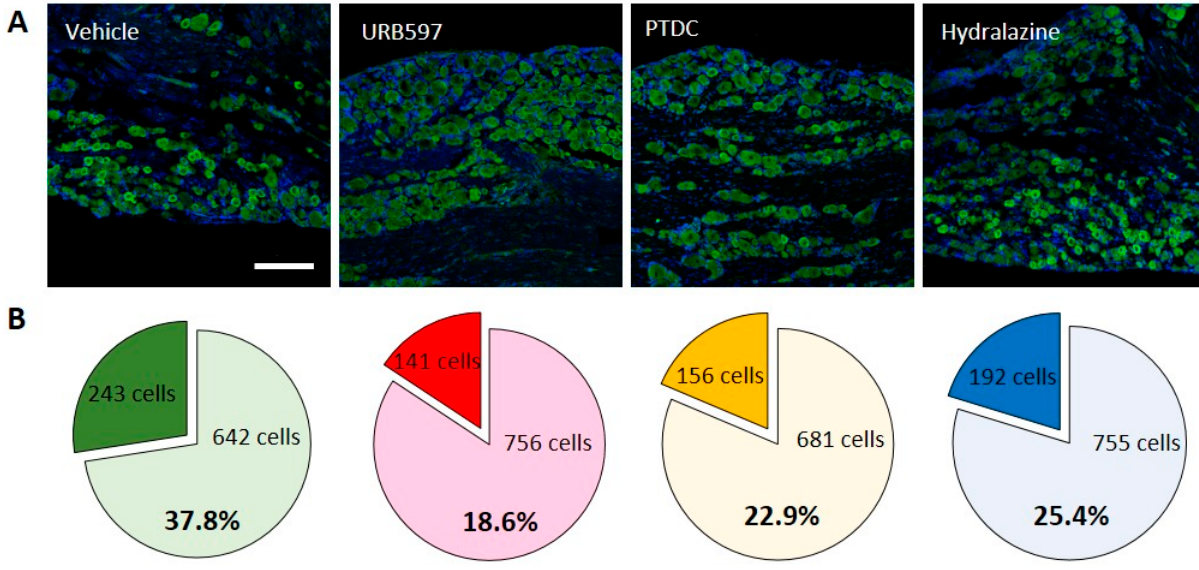
Figure 2. Activation of Nav1.7 channels in DRGs of the CPIP model. In DRG sections, immunohistochemical evidence showed that the expression of Nav1.7 increased in CPIP-injured rats. ( A ) Comparison of Nav1.7 expression in vehicle, URB597, PTDC, and Hydralazine injection groups. ( B ) Pie charts showing the percentage of DRG neurons expressing Nav1.7 among all treated drugs. The upper number indicates the number of Nav1.7-expressing neuron cells, and the lower number indicates the non-expressing neuron cells.